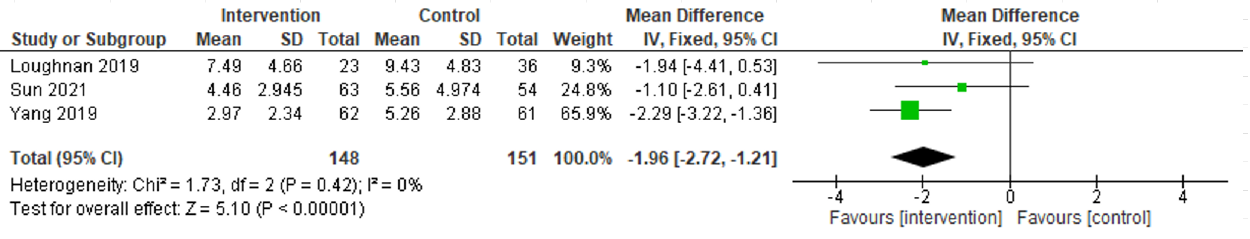
Figure 4 . Anxiety symptoms at the endpoint.